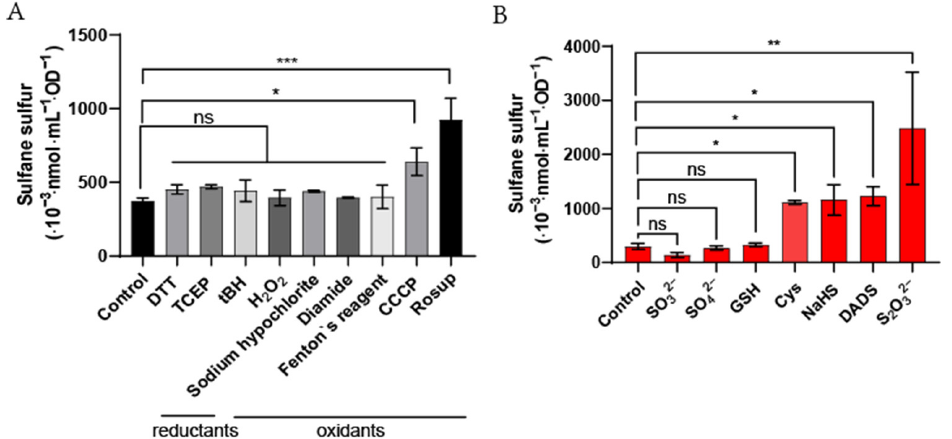
Figure 7. Changes in the iSS content of E. coli cells under different oxidants, reductants, and sulfur- bearing compounds. ( A ) E. coli BL21(DE3) cells were cultured until their OD 600 reached 1.0. Then, the cells were aliquoted, and different oxidants and reductants were added and incubated with them for 30 min before iSS detection. The DTT, TCEP, tBH, H 2 O 2 , sodium hypochlorite, diamide, Fenton’s reagent, CCCP, and Rosup were used at 1, 0.2, 0.25, 0.1, 0.1, 1, 0.1 mM, 10 μ M, and 50 μ g/mL, respectively. ( B ) Different sulfur-bearing compounds at 10 mM were added and incubated with the cell cultures for 30 min before iSS detection. Three parallel experiments were performed to obtain the averages and standard deviations (n = 3). The One-way ANOVA method was performed to calculate the p -values (ns, p ≥ 0.05; *, p < 0.05; **, p < 0.01; ***, p < 0.001).